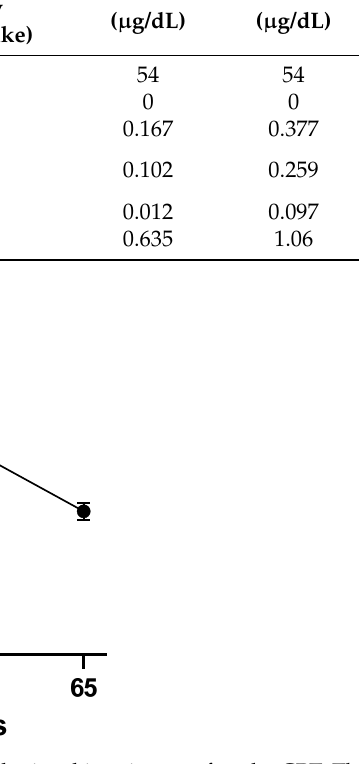
Figure 1. Mean ( ± SEM) cortisol depicted in minutes after the CPT. The baseline measurement before the CPT is depicted as “0” minutes. Table 2. Intercorrelations between covariates. Correlation Matrix.